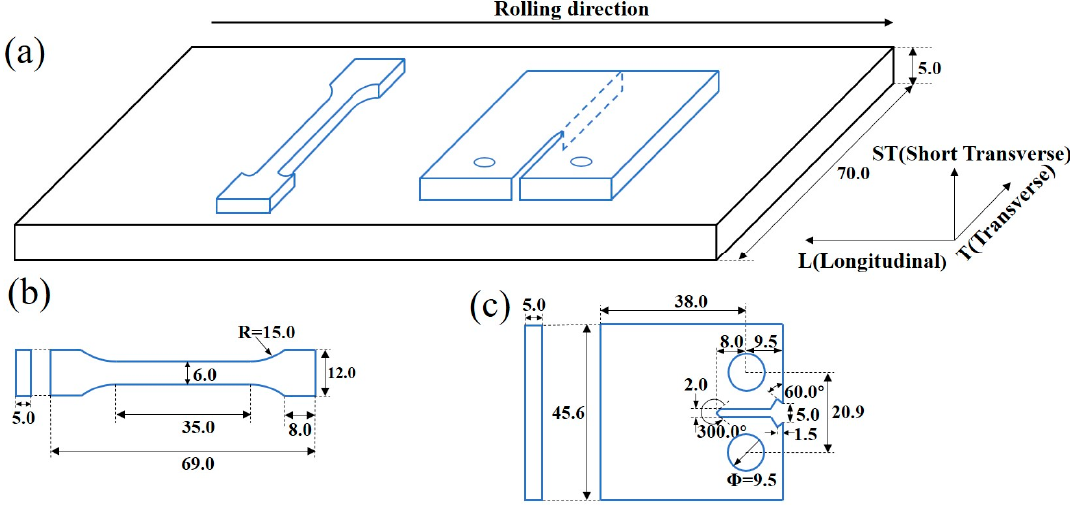
Figure 1. Schematic diagrams showing the specimens for tensile and fatigue crack propagation (FCP) tests: ( a ) the orientation and location of the specimens taken from the rolling plates, the geometry and dimensions of the ( b ) tensile and ( c ) FCP specimens. (unit in mm).